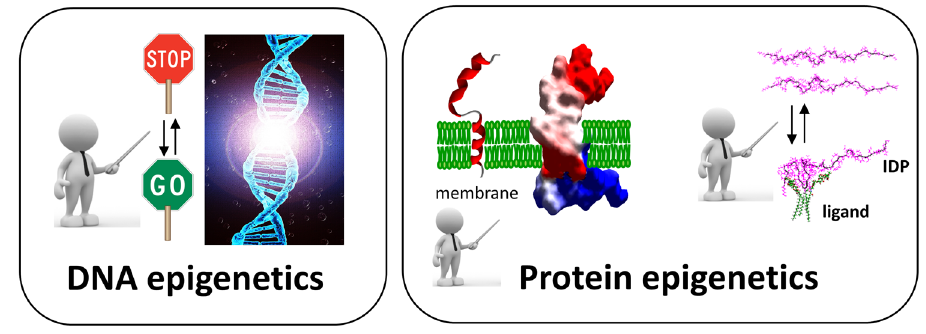
Figure 6: The epigenetic dimension of protein structure: a new paradigm. Left panel. Epigenetics modi fi cations of DNA alters which genes are on or o ff , in response to environmental parameters, with no alteration of DNA sequence. This biological information is translated into a go no go decision of gene expression. Post - translational modi fi cations of histones and DNA methylation play a key role in these mechanisms. Right panel. Epigenetics modi fi cations of proteins alter their conformation, in response to environmental parameters, with no alteration of amino acid sequence. This biological information is translated into conformational guidelines. Biological membranes and ligand binding for IDPs play a critical role in these mechanisms. In both cases ( DNA and protein epigenetics ) , the biological information can be transmitted from biomolecule to